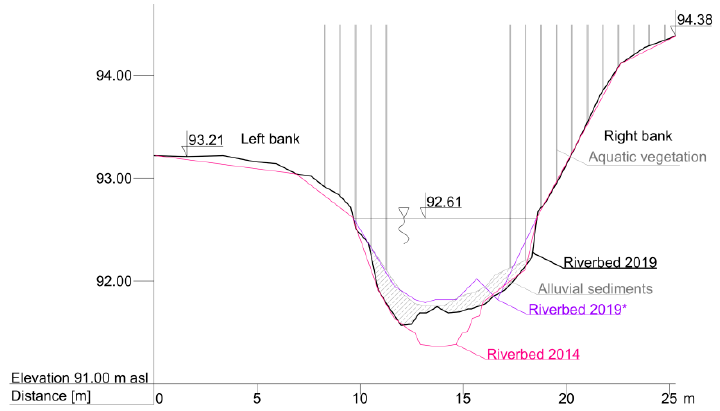
Figure 3. Bed changes in cross-section no. 1 (in an area with no tree cover—with submerged and emergent vegetation).